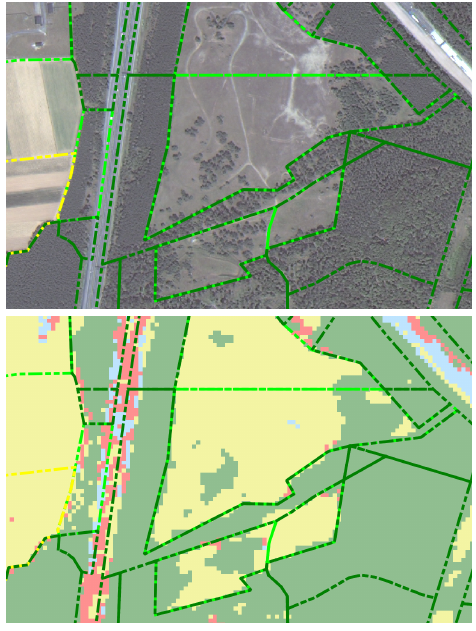
Figure 1: Satellite image and image analysis result. Each colour represents a different kind of texture. GIS object borders describe the GIS features.